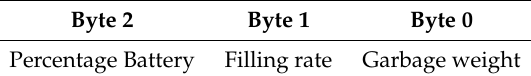
Table 7. Bytes sent by the trash monitor sensor at the frame payload in the application layer through the LoRa